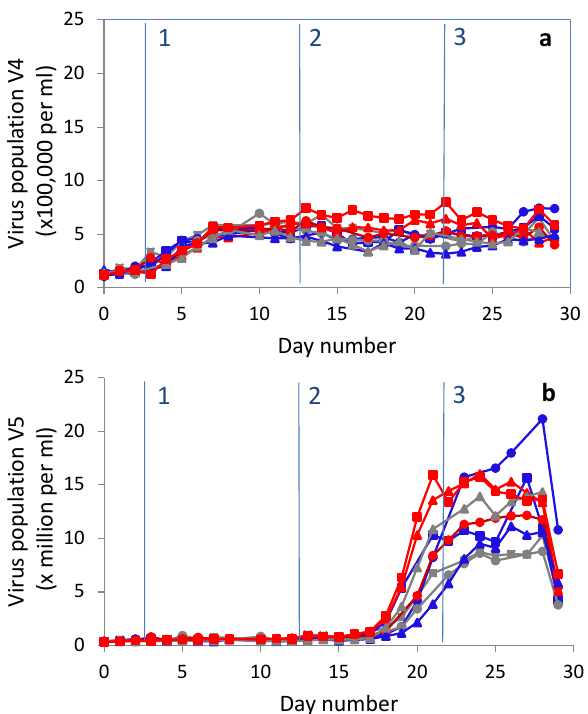
Fig. 6. Temporal dynamics of virus cluster V4, indicative of larger algal viruses infecting nanophytoplankton I (a) , and V5, most likely infecting picophytoplankton I (b) . For color and symbol coding, see Fig. 1. Note the different y-axis